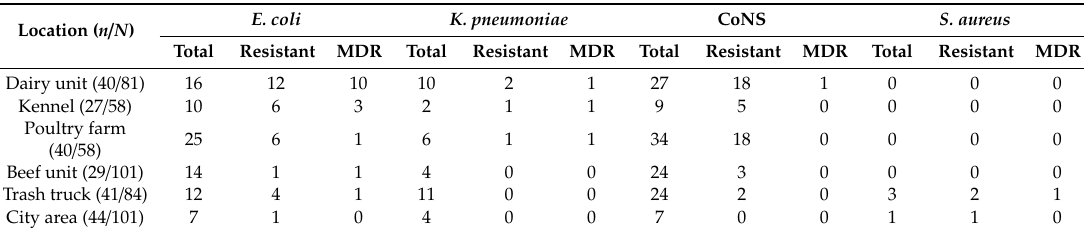
Table 1. Antimicrobial susceptibility of bacterial isolates isolated from